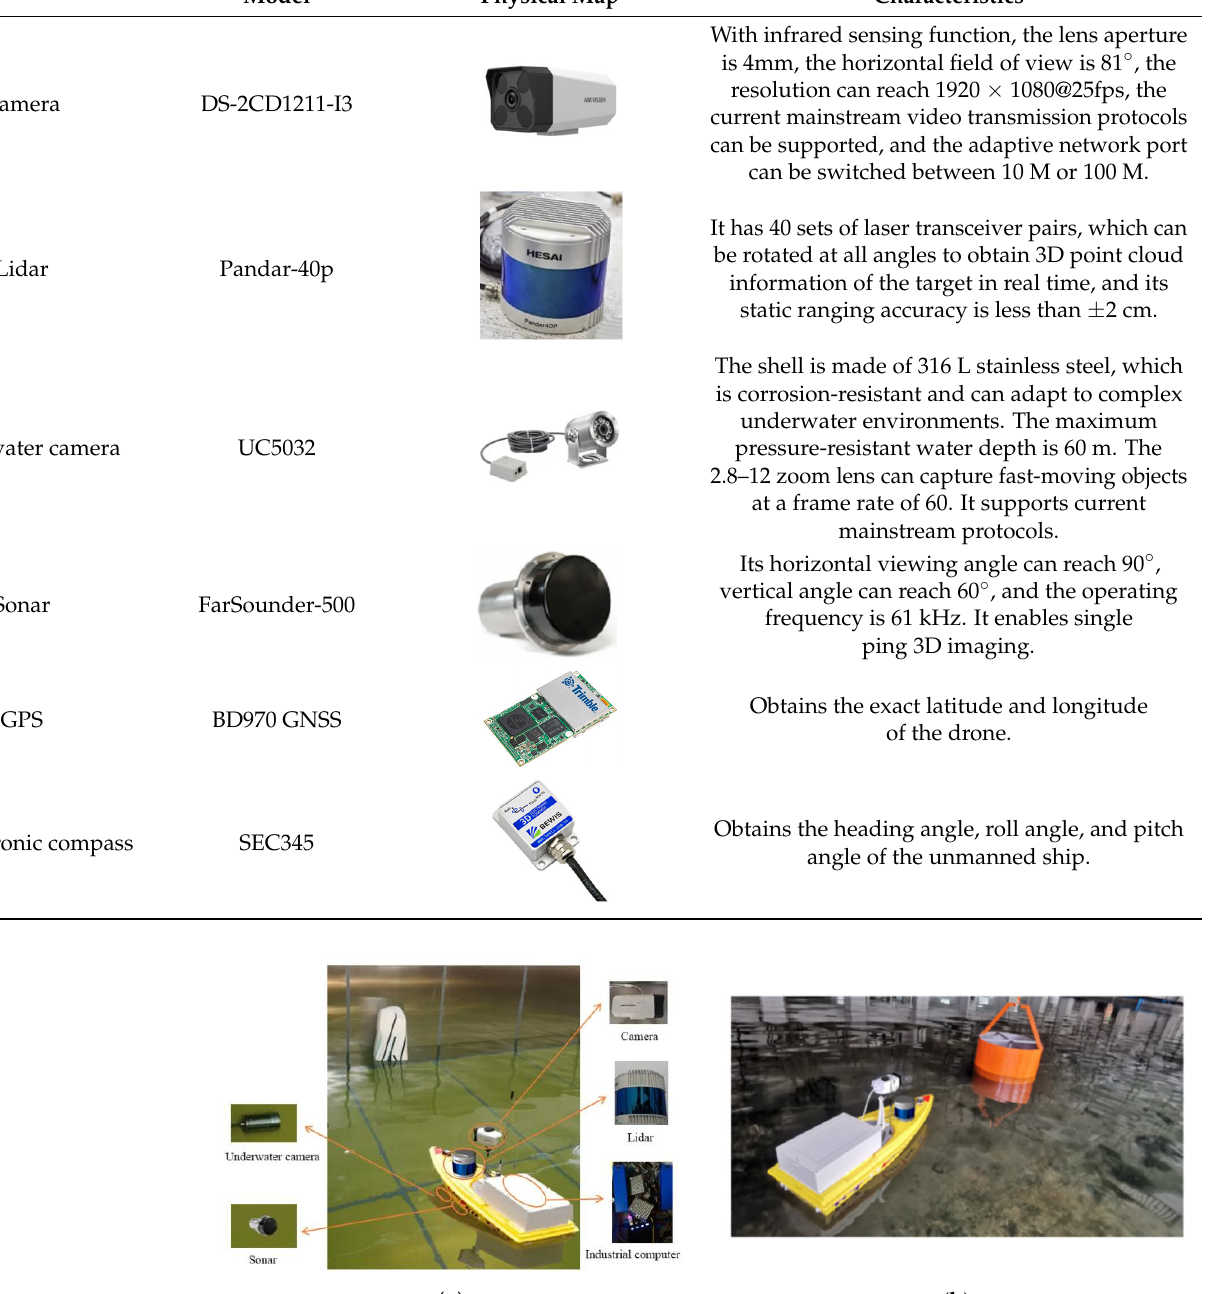
Table 4. Experiment running environment information. Category